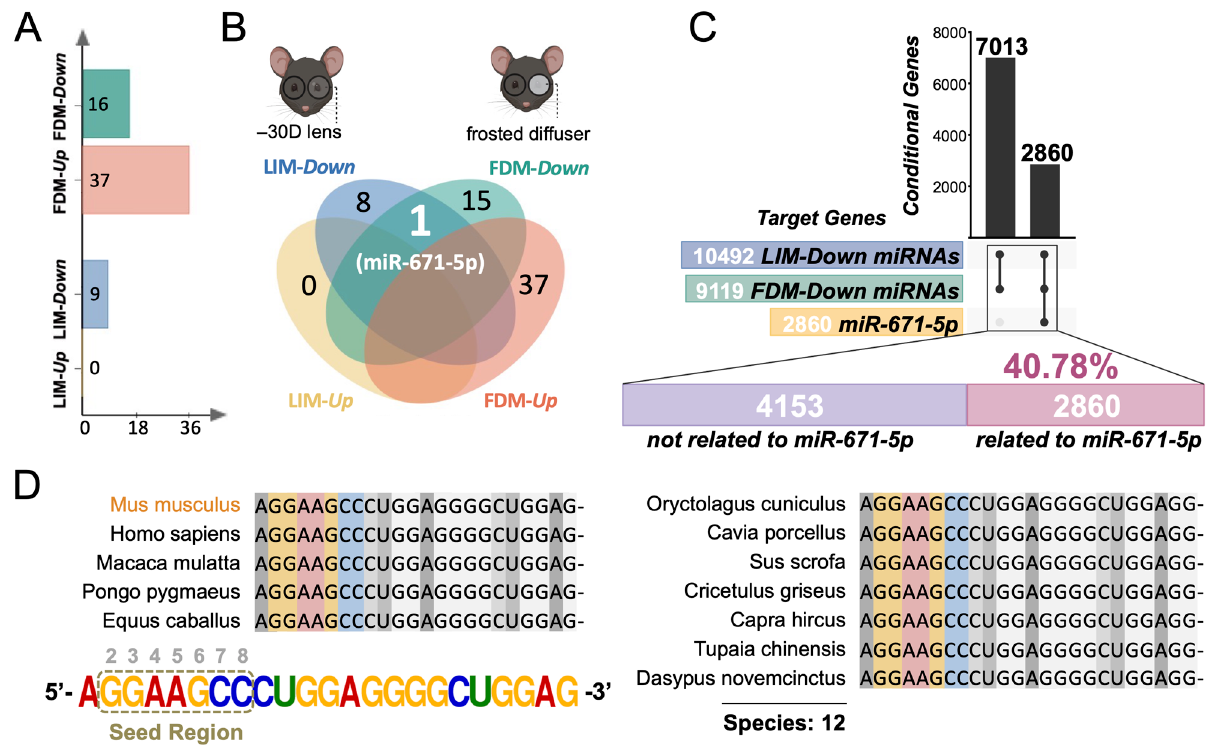
Figure 1. Identification and characterization of miR-671-5p as the shared downregulated miRNA in LIM and FDM mouse models. ( A ) Differentially expressed miRNAs in the retinas of LIM and FDM mouse models. The numbers on the bars represent the total differentially expressed miRNAs in each group. X-axis: numbers of differentially expressed miRNAs. Y-axis: the name of each group. ( B ) miR-671-5p is concurrently downregulated in the retinas of both LIM and FDM mice. ( C ) A total of 40.78% of all the target genes of the downregulated miRNAs in the LIM and FDM retinas are related to miR-671-5p. ( D ) Comparison of miR-671-5p seed sequences between 12 different species.